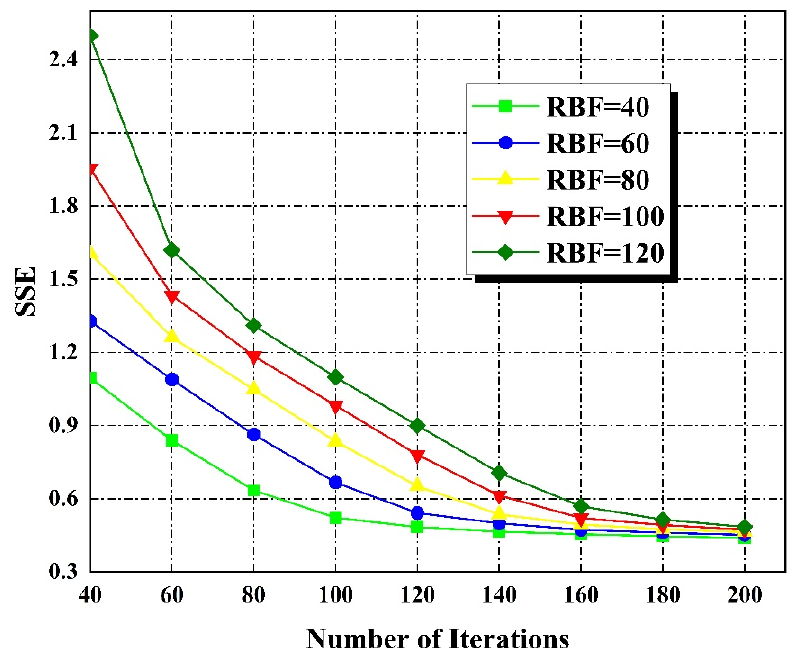
Figure 10. Number of iterations versus SSE for selected number of